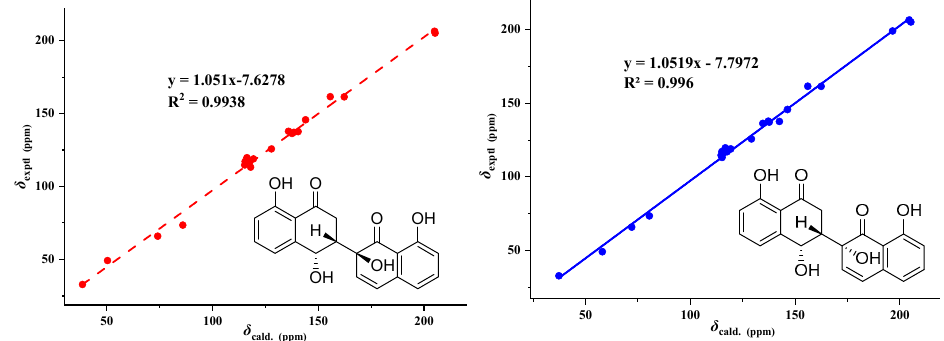
Figure 5. Linear regression analysis between experimental and calculated 13 C NMR chemical shifts of isomers of 1 .